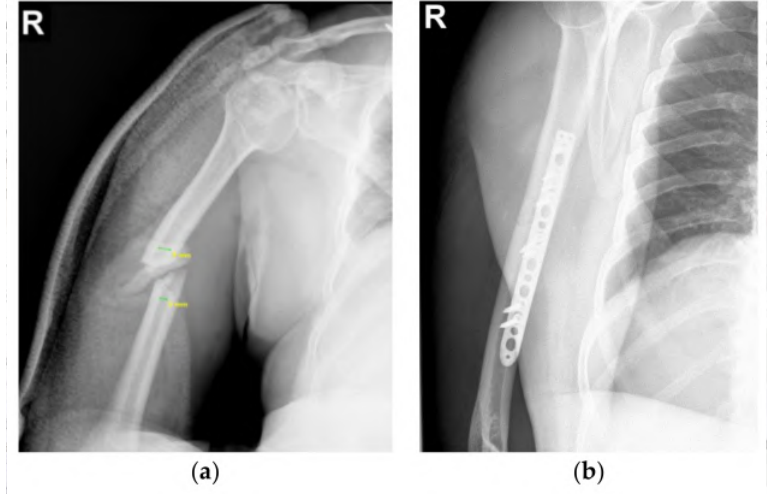
Figure 1. Clinical details: ( a ) X-ray comminuted fracture of midshaft humerus; ( b ) Post-operative X-ray with reduction and osteosynthesis with the locking compression plate (LCP).